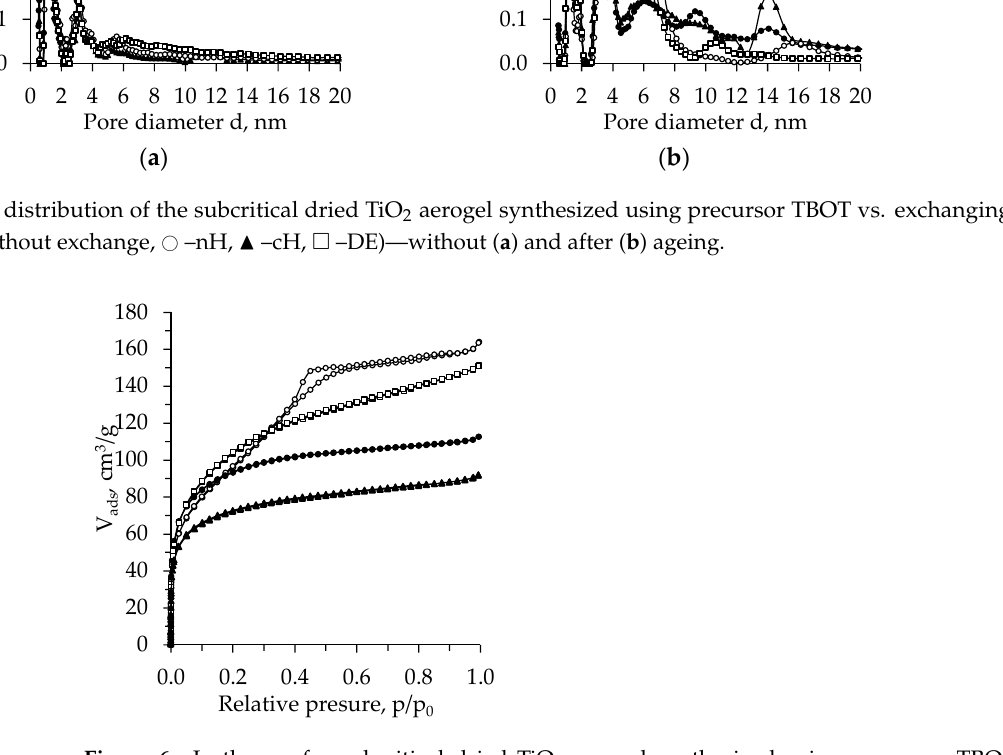
Figure 5. Pore size distribution of the subcritical dried TiO 2 aerogel synthesized using precursor TBOT vs. exchanging solvent type (  –without exchange,  –nH, ▲ – cH,  –DE)—without ( a ) and after ( b ) ageing.